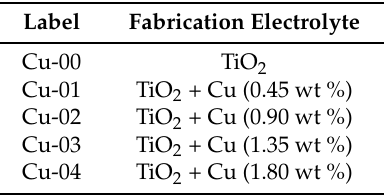
Table 5. Experimental parameters of the prepared